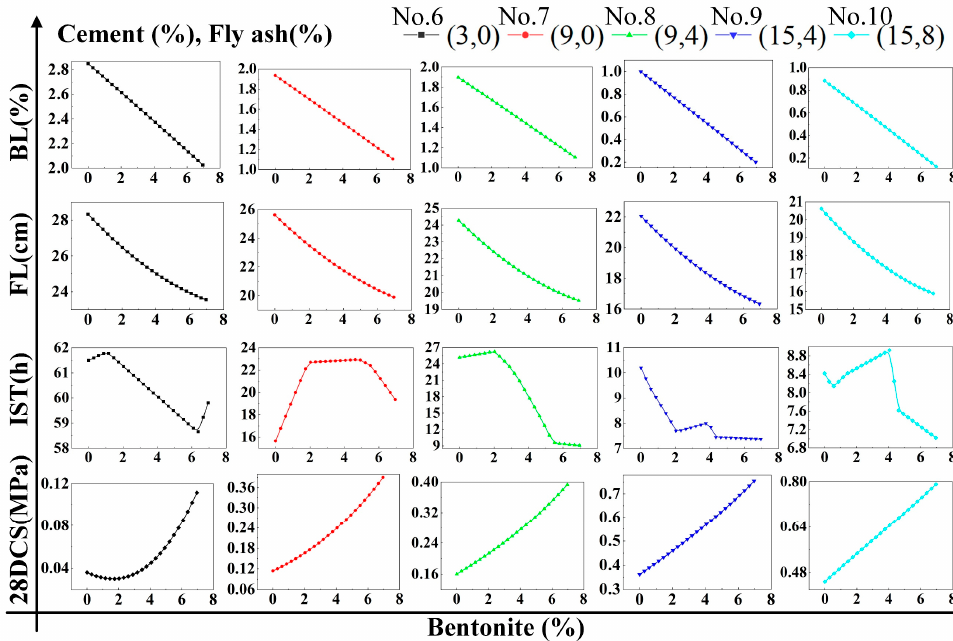
Figure 22. Influence of BE content on DWS-GM. Figure 22. In fl uence of BE content on DWS-GM. Figure 22. In fl uence of BE content on DWS-GM.